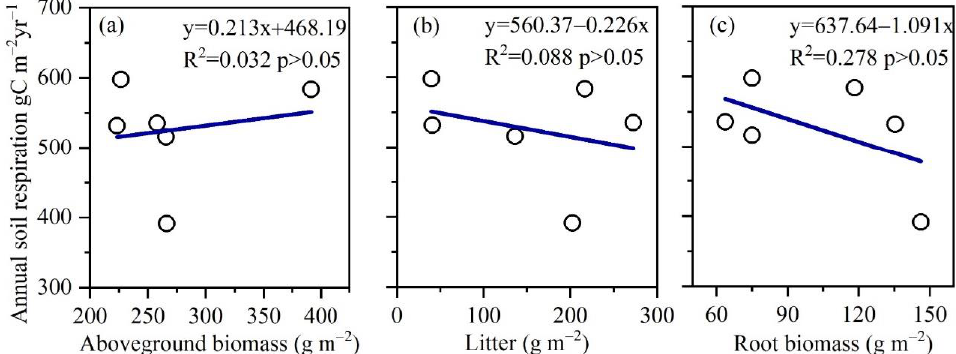
Figure 6. Relationships between annual measures of soil respiration and phytomass components: ( a ) above biomass, ( b ) litter, and ( c ) root biomass.